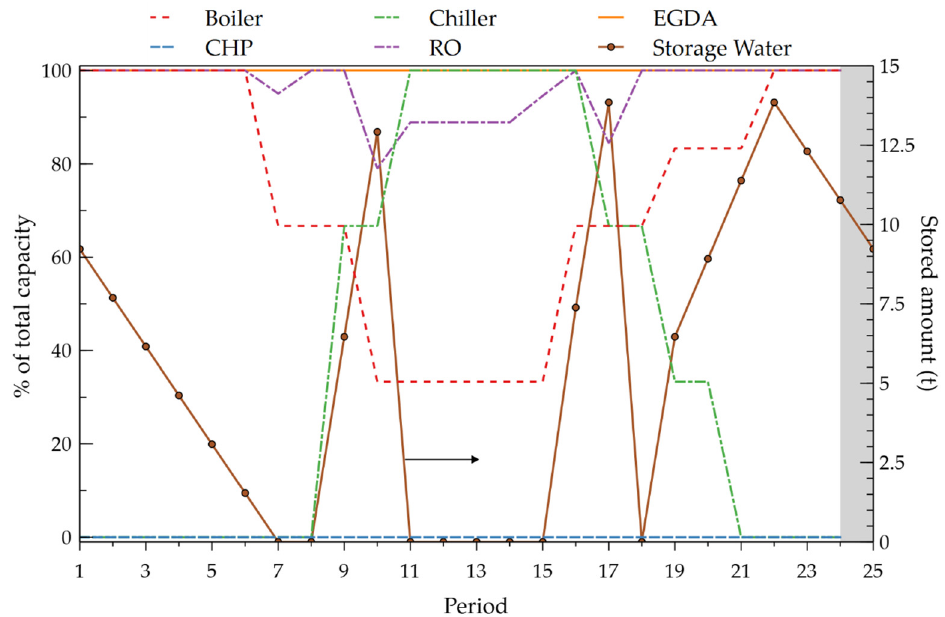
Figure 7. Operating state of solution 51 for the case with no limitation of CO 2 emissions.